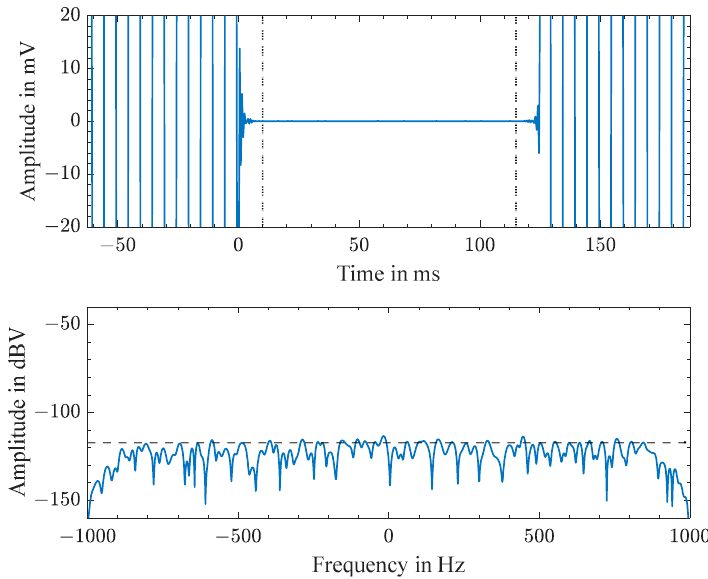
Figure 6. Measured time-domain signal without attached resonator ( top ) and corresponding time- gated echo signal in the frequency domain ( bottom ).